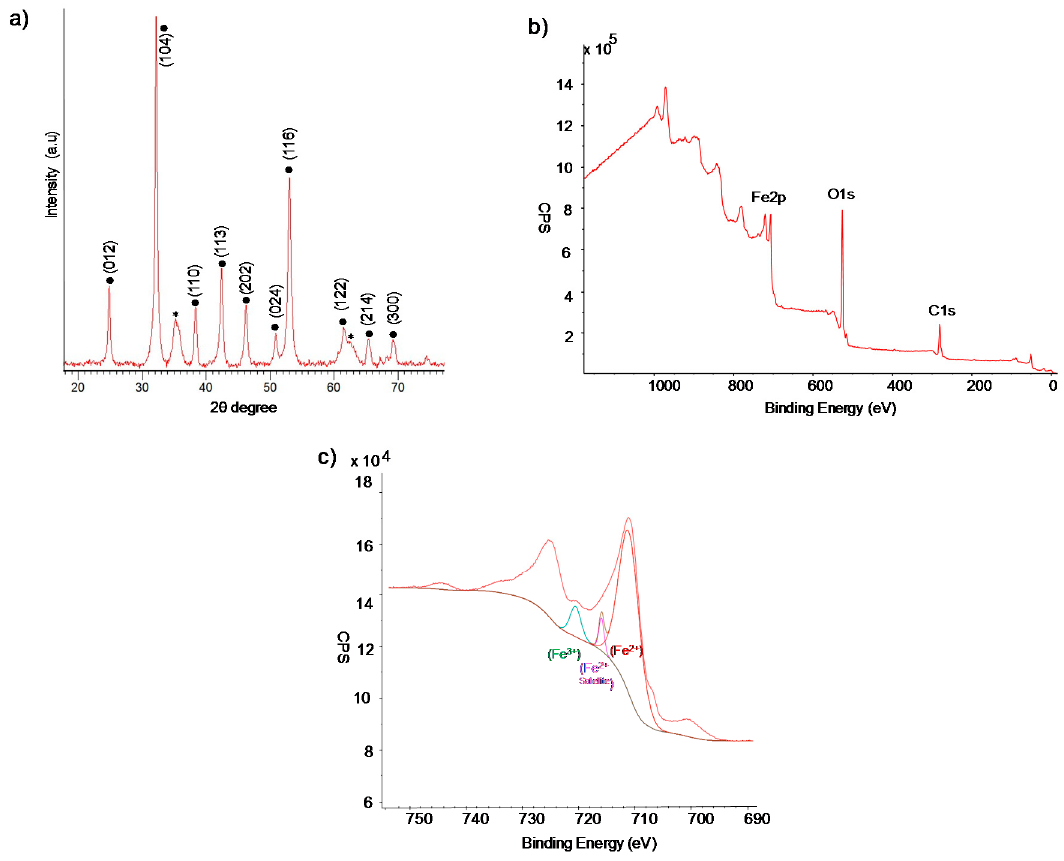
Figure 2. X ‐ ray characterization of bionanohybrid. ( a ) XRD pattern ( ● FeCO 3 , * iron oxide impurity.). Figure 2. X-ray characterization of bionanohybrid. ( a ) XRD pattern ( FeCO 3 , * iron oxide impurity.). ( b ) XPS spectrum. ( c ) XPS Fe2p spectrum. ( b ) XPS spectrum. ( c ) XPS Fe2p